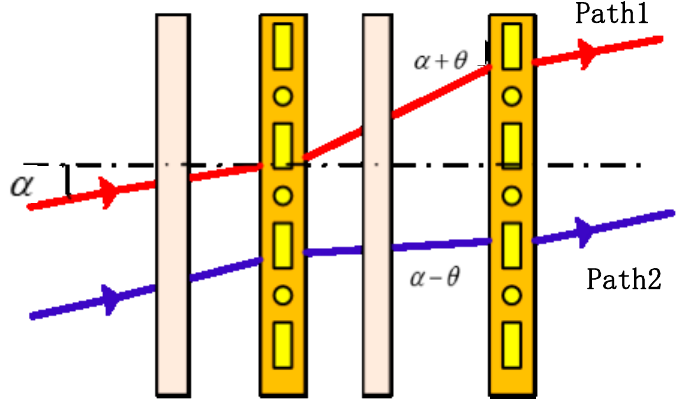
Figure 6. Optimization control coefficient